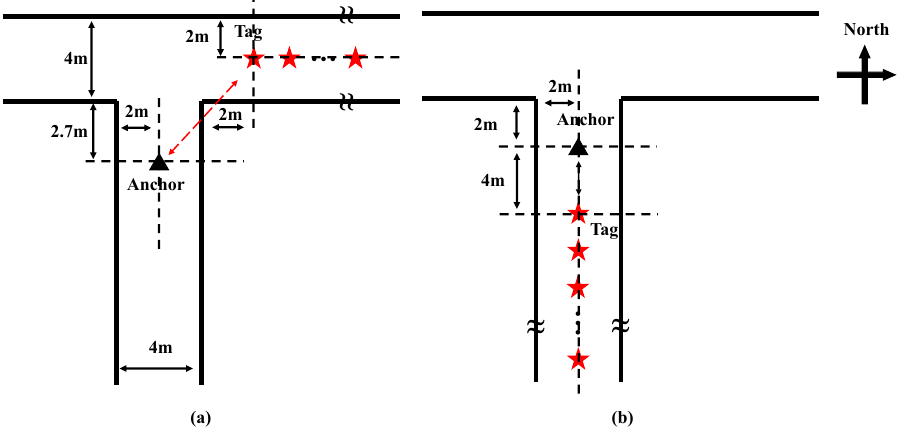
Figure 13. An experimental scenario for collecting data for training the model network. The black thick solid line indicates the boundary of the environment, and the red bidirectional arrows indicate the mutual ranging devices (dotted line indicates the NLOS, solid line indicates the LOS). The red five-pointed star indicates the position of the tag. ( a ) Data collection for non-line-of-sight situations, ( b ) Data collection for line-of-sight situations.